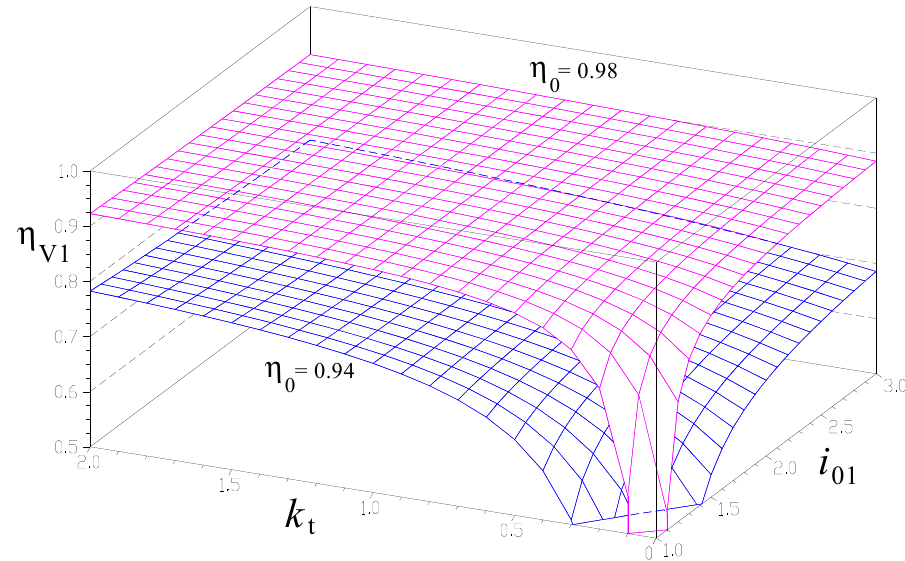
Figure 6. Efficiency of the 1-DOF speed increaser variant V1 (Figure 5a) as function of the interior kinematic ratio i 01 , torque ratio k t , and efficiency of each gear-pair η 0 = 0.98.